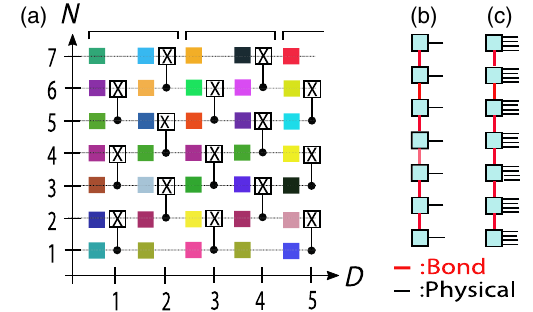
FIG. 1. (a) Sketch of the quantum circuit with N qubits. The colored squares indicate arbitrary 1-qubit gates while the dots connected to a cross indicate a 2-qubit gate such as control- NOT or control- Z . The depth D counts the number of 2-qubit gates performed in the sequence. (b) Structure of the matrix product states (MPS) for 1D circuits. Red lines indicate bond (or virtual) indices while thin black lines correspond to physical indices.